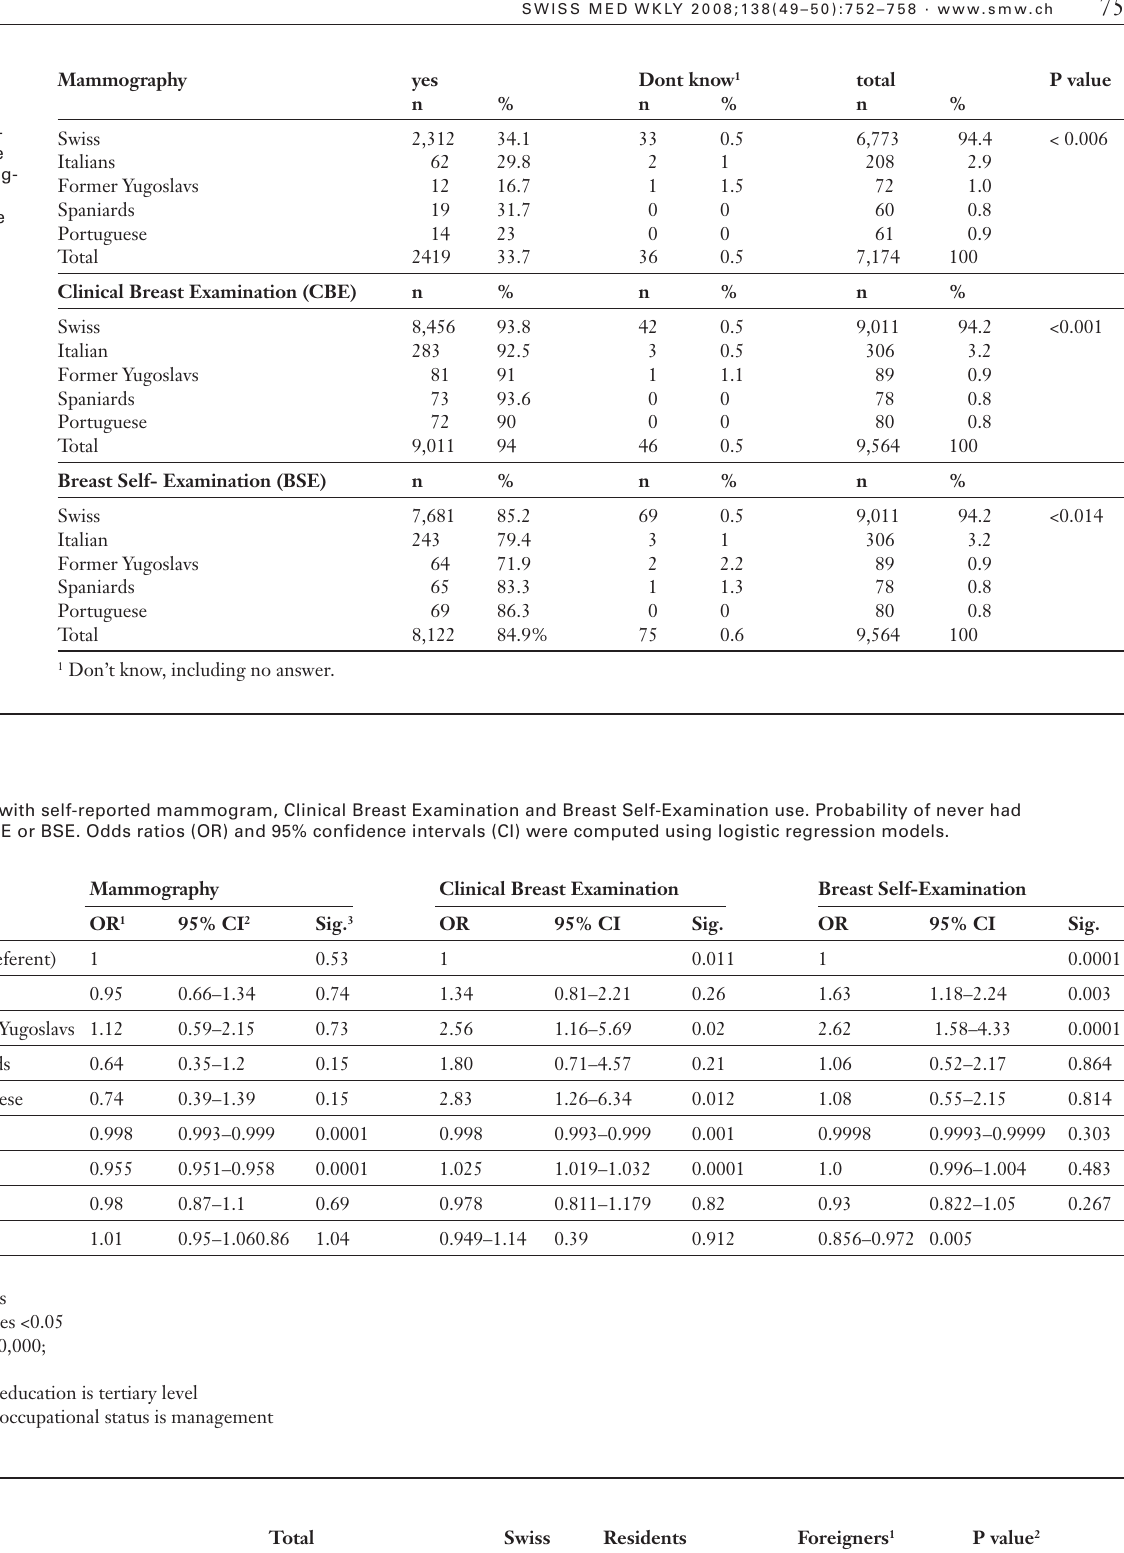
Mammography up- take, women aged >50, n = 3098, sample dichotomised into Swiss residents vs foreigners and